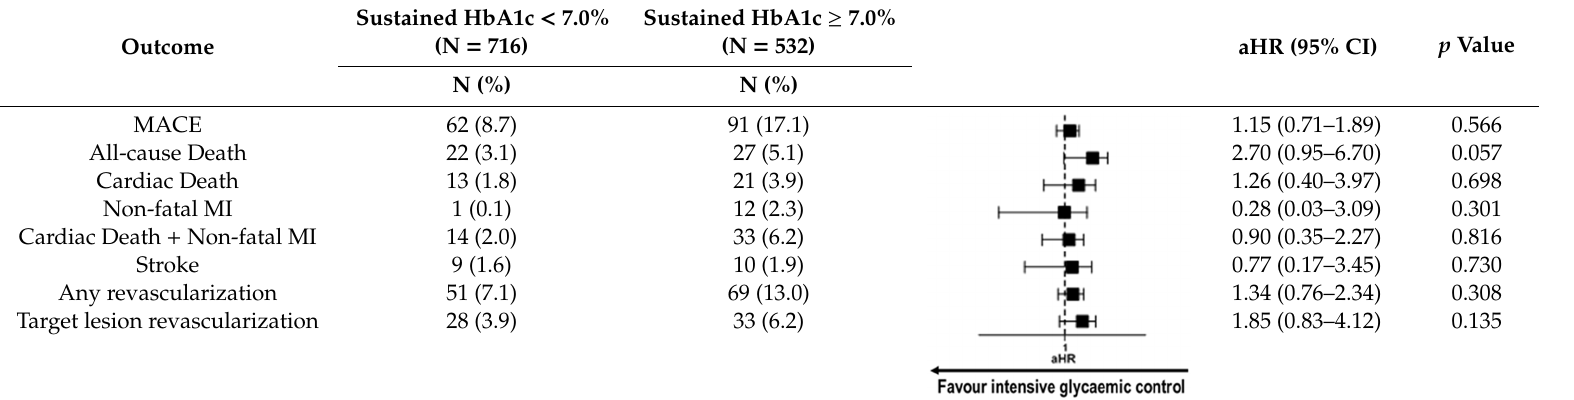
Table 3. The impact of stable glycemic control during follow-up on clinical outcome after PCI.